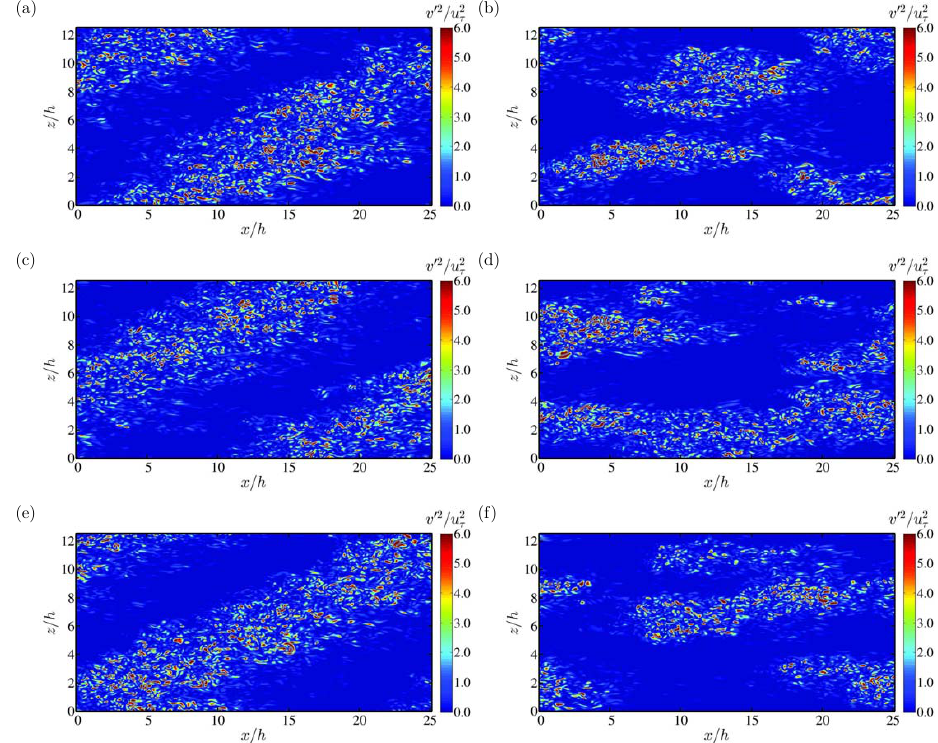
Figure 9. Instantaneous contours of v (cid:48) 2 at different times ( Re τ = 180). The x – z planes are located at y + = 45. (a) Ri τ = 120, t ∗ = 36, (b) Ri τ = 240, t ∗ = 36, (c) Ri τ = 120, t ∗ = 38, (d) Ri τ = 240, t ∗ = 38, (e) Ri τ = 120, t ∗ = 40, and (f) Ri τ = 240, t ∗ =